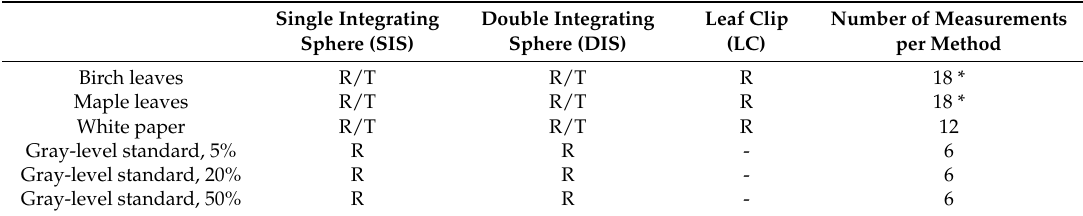
Table 1. Measured samples and quantities (R = reflectance, T = transmittance) with each method. Single Integrating Double Integrating Leaf Clip Sphere (SIS) Sphere (DIS)